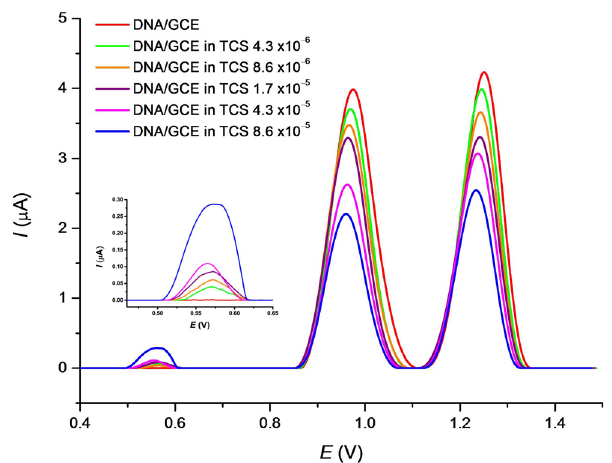
Figure 3. SWV curves recorded after 15 min. incubation of the DNA/GCE biosensor in TCS solu- tions of various concentration in 0.1 mol·L − 1 PB pH 7.4. SWV conditions: amplitude 20 mV, fre- 50 Hz, step potential 4 mV and scan rate 200 mV · s − 1 quency 50 Hz, step potential 4 mV and scan rate 200 mV·s − 1 .